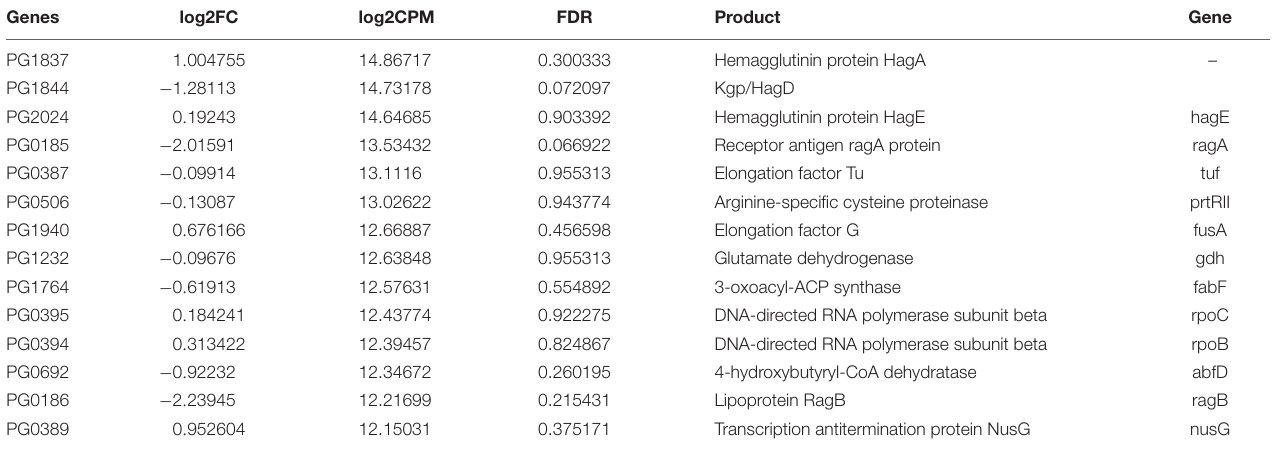
TABLE 2 | Highly expressed genes (log2CPM ≥ 12) in both periodontitis and laboratory culture in P. gingivalis. Genes log2FC log2CPM FDR Product Gene